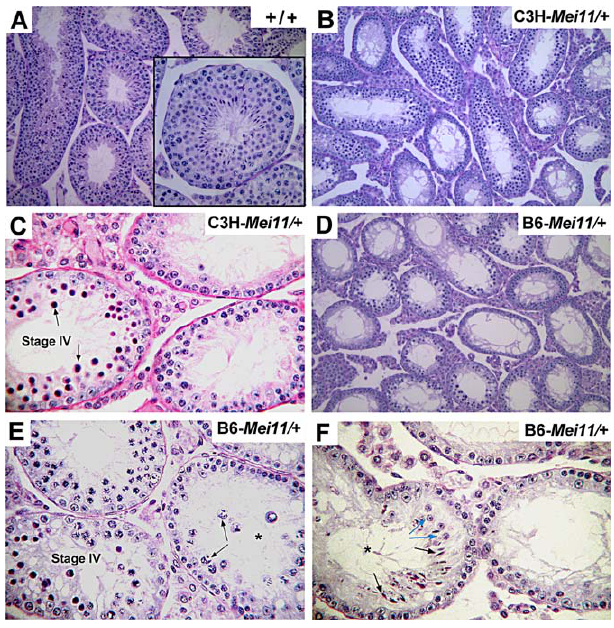
Figure 1. Histopathology of Mei11 Mutant Testes Paraffin-embedded adult testes sections were stained with hematoxylin and eosin (A–D) or periodic acid–Schiff (E and F). Genotypes are indicated. (A, B, and D) Images are at 20 3 , except for inset (60 3 ). (C) Dying spermatocytes (arrows) are in an epithelial stage IV semi- niferous tubule (60 3 ). (E) Incomplete meiotic arrest. The seminiferous tubule marked with an asterisk contains mid-pachytene spermatocytes (arrows). 60 3 . (F) A rare tubule (asterisk) containing round spermatids (blue arrows) and elongating spermatids (black arrows). 60 3 .